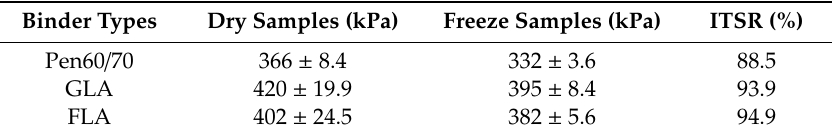
Figure 13. Indirect tensile strength (ITS) test results before and after freeze–thaw cycle. Table 8. The ITS and ITSR values of test